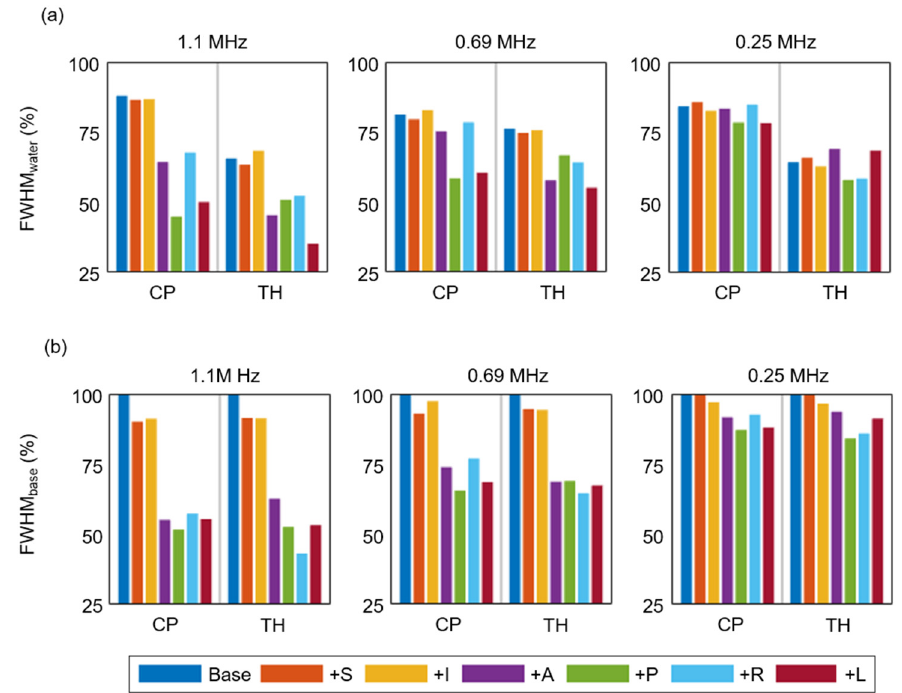
Figure 6. Effects of transducer displacement on ( a ) FWHM water and ( b ) FWHM base at 1.1, 0.69, and 0.25 MHz. The transducer was displaced by 0.5 mm in all six directions—+S, +I, +A, +P, +L, and +R—relative to its base location.